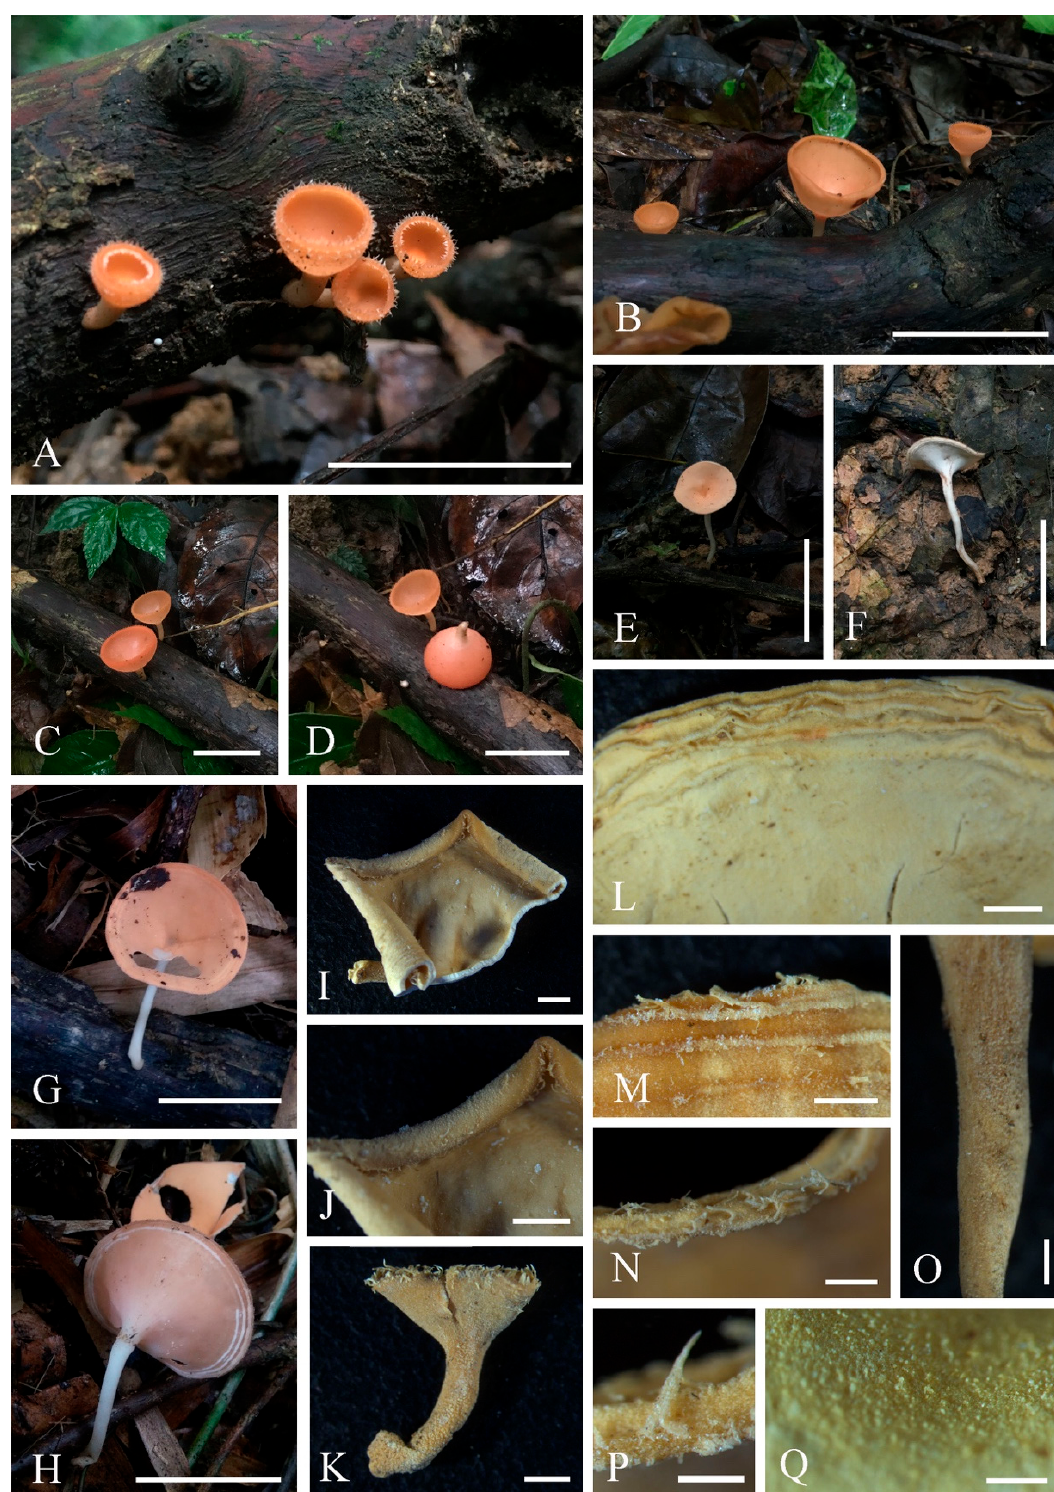
Figure 7. Cookeina speciosa . ( A – H ) Fresh apothecia [( A , B ). HKAS 121188. ( C , D ) HKAS 121186. ( E , F ) HKAS 121187. ( G , H ) MFLU 21-0157.] ( I , K ) Dry apothecia [( I ) HKAS 121186. ( K ) HKAS 121188.] ( J ) Margin (HKAS 121186). ( L , M ) Concentric ridges [( L ) MFLU 21-0157. ( M ) HKAS 121182.] ( N ) Compound hairs (MFLU 21-0157). ( P ) Triangular-shaped hairs (MFLU 21-0157). ( O ) Stipe (MFLU 21-0157). ( Q ) Receptacle surface of an apothecium (MFLU 21-0157). Scale bars ( A , B , E , F ) = 5 cm; ( C , D , G , H ) = 3 cm; ( I – L ) = 2000 μ m; ( M – O ) = 1000 μ m; ( P , Q ) = 500 μ m.